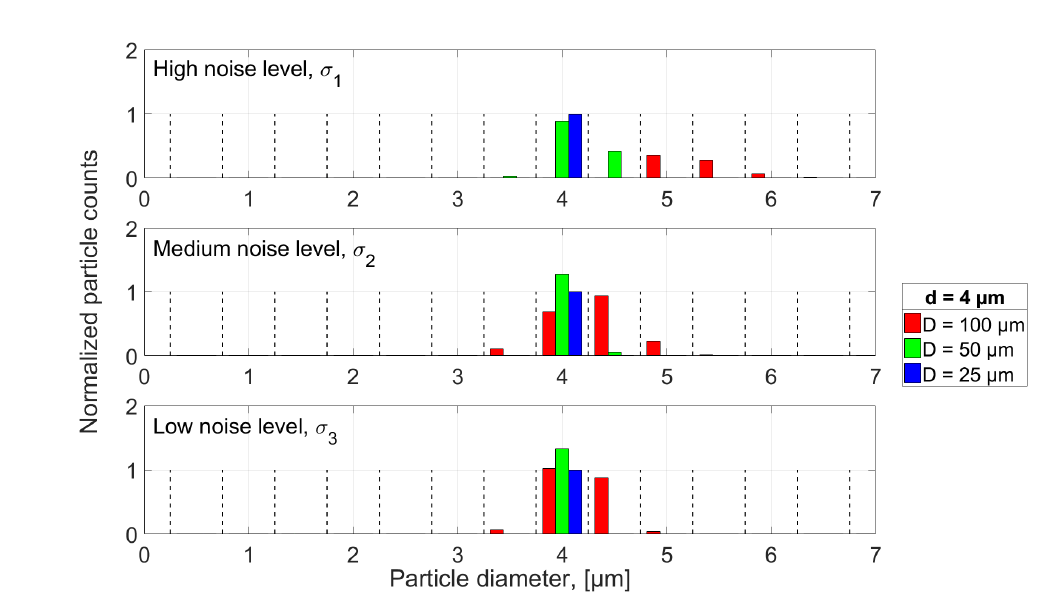
Figure 15. Histogram presentation of the number of particles that have been detected by the algorithm in the noisy signals, where the bin width is equal to 0.5µm and the height has been normalized according to the true number of particles that have been used in the simulation, enabling the bin value to be greater than